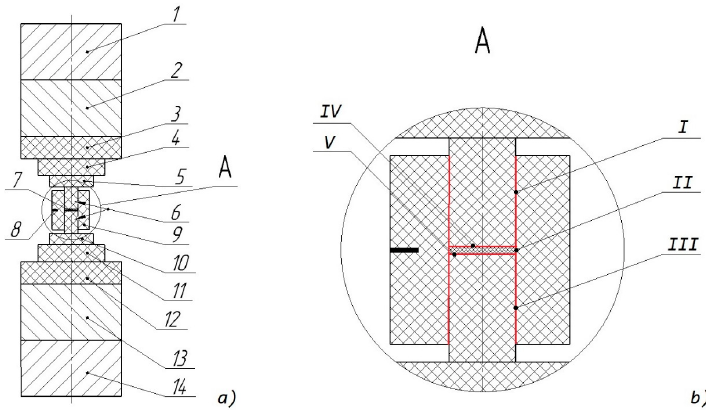
Figure 2. Front view of the spark plasma sintering (SPS) setup ( a ), an enlarged view of the specimen and the mold ( b ); positions I–V are contact interfaces.